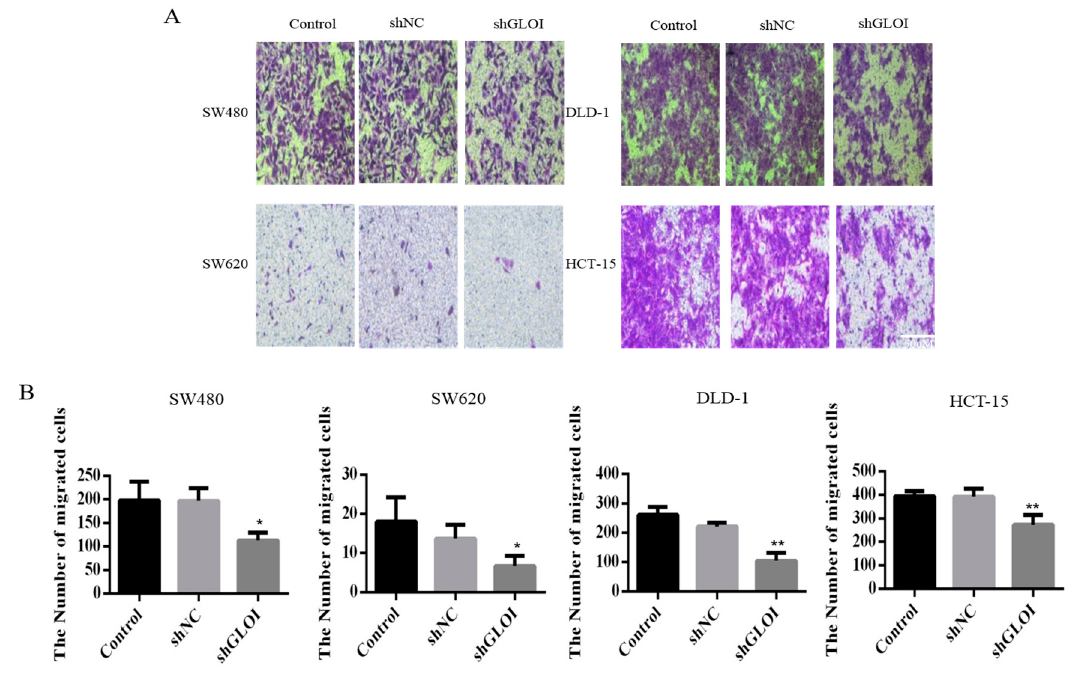
Figure 5. GLOI knockdown inhibits migration of colorectal cancer (CRC) cells. ( A , B ) SW480, SW620, DLD-1, and HCT-15 CRC cells were transfected with shGLOI or shNC (empty vector) and their migration was evaluated by their penetration of a transwell insert membrane. * p < 0.05, ** p < 0.01. All data are representative of three independent experiments ( n = 3).